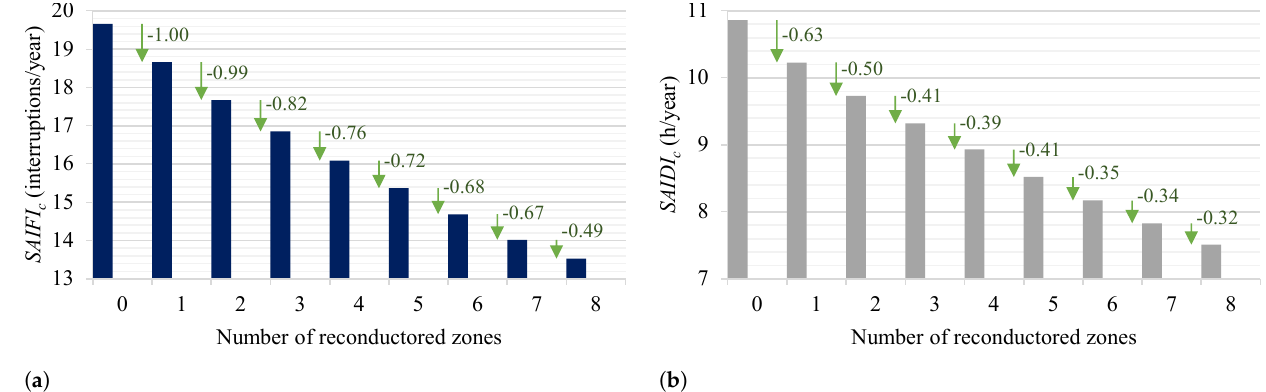
Figure 12. Impact of reconductoring on reliability indices. ( a ) SAIFI c . ( b ) SAIDI c